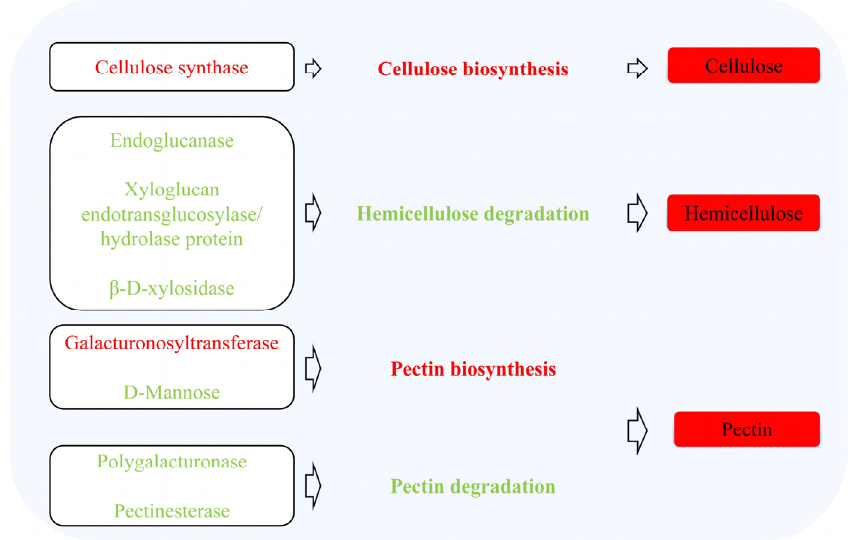
Figure 7. Blue light regulates cellulose, hemicellulose, and pectin metabolism in the hypocotyl. Red text indicates upregulation and green text indicates downregulation. Red solid cubes indicate increased cellulose, hemicellulose, and pectin contents.